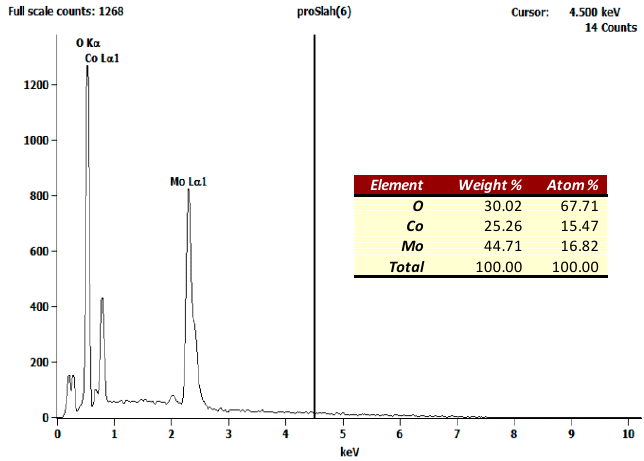
Figure 6. EDX spectrum of the as synthesized β -CoMoO 4 and its atomic abundance.